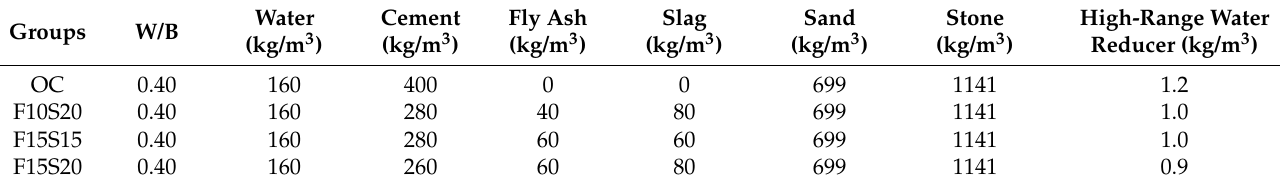
Table 3. The mix proportion of